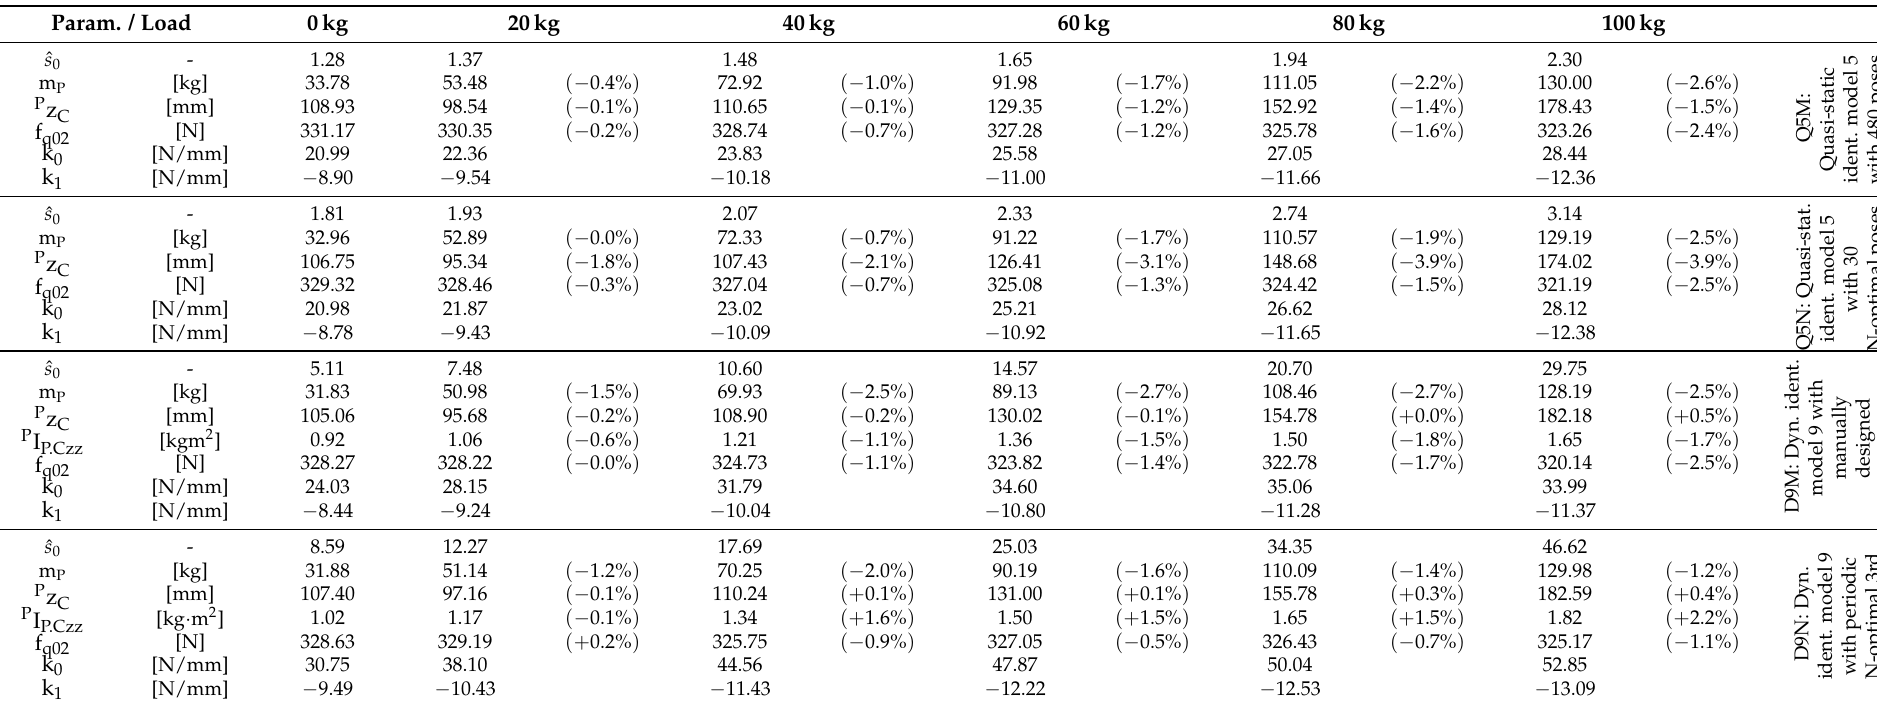
Table 7. Selected identified parameters and relative differences to the theoretical physical values of benchmark payloads for quasi-static and dynamic approaches; characteristics of each applied mass step: m = 19.93kg, h = 60mm, x C = { 0,10.3,31.1 } mm, I zz = 0.1536kgm 2 . Param. /